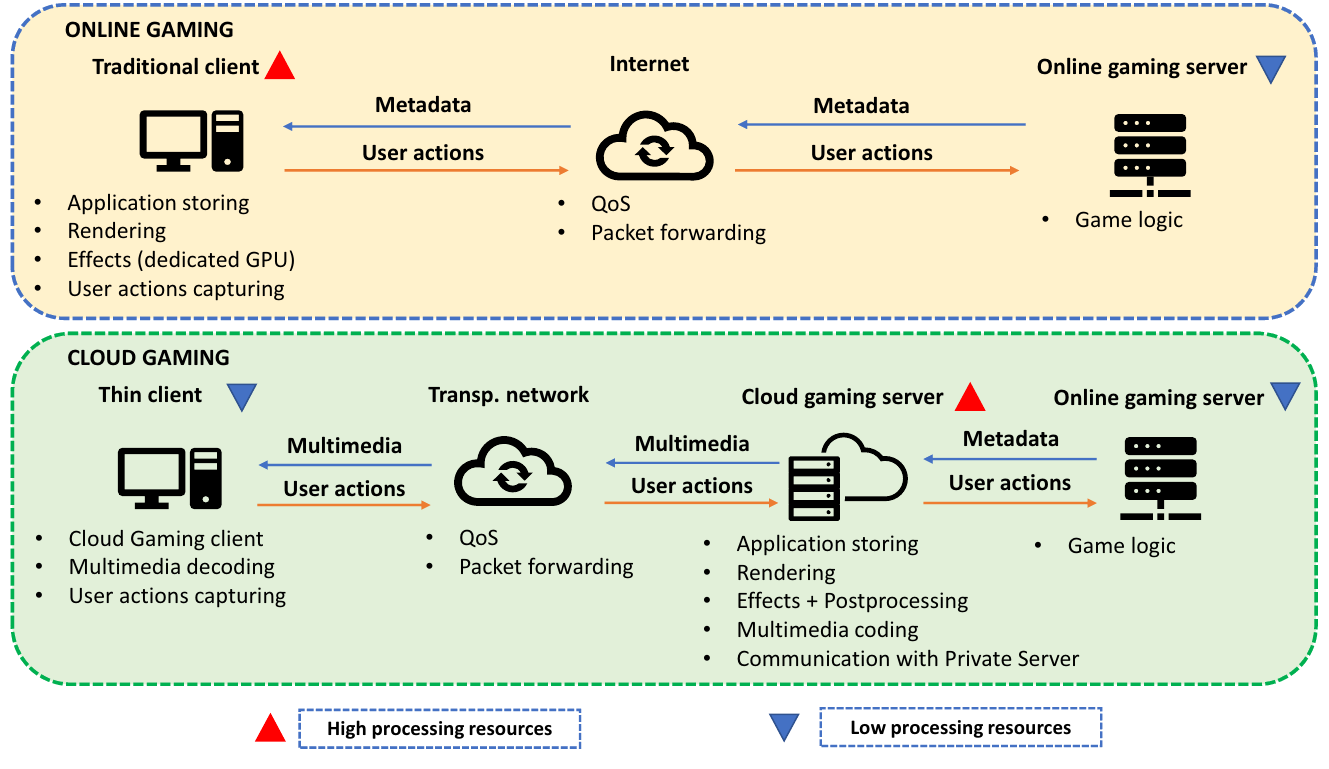
Figure 1. Online and Cloud Gaming